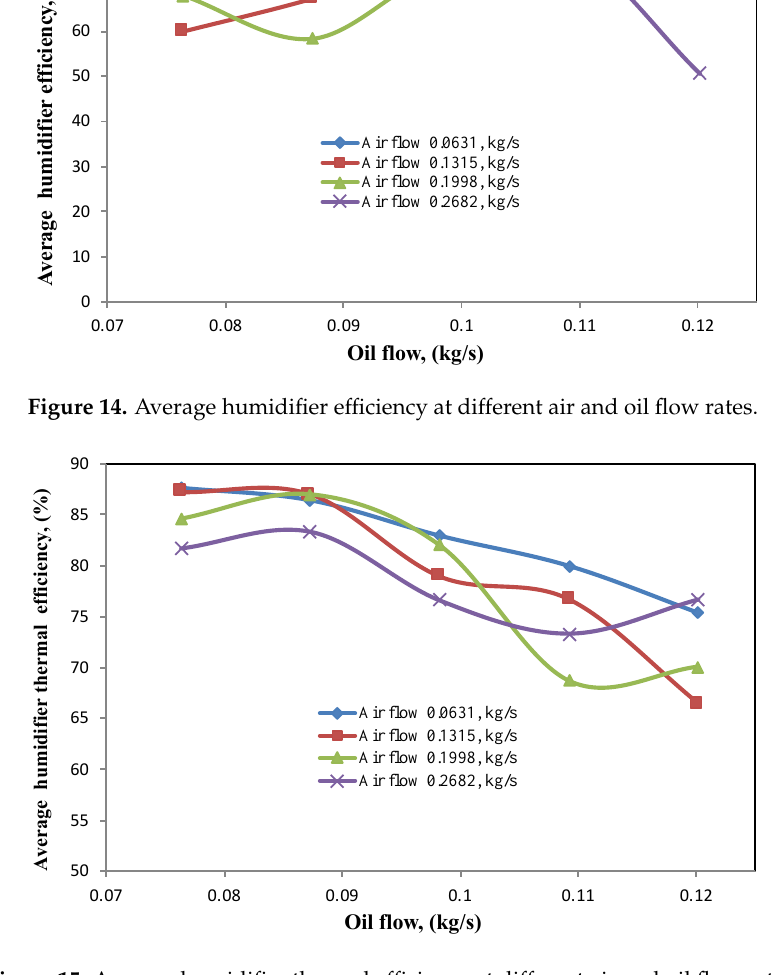
Figure 15. Average humidifier thermal efficiency at different air and oil flow rates.